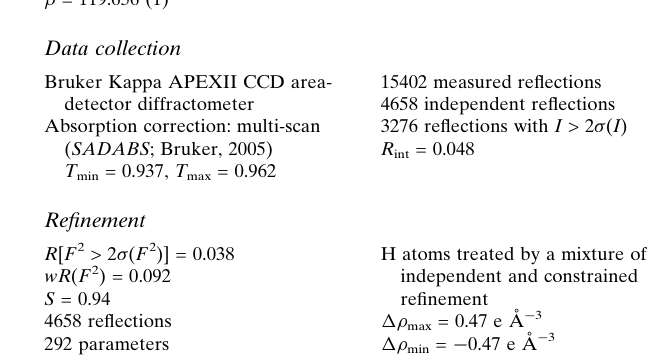
Data collection Bruker Kappa APEXII CCD area- detector diffractometer